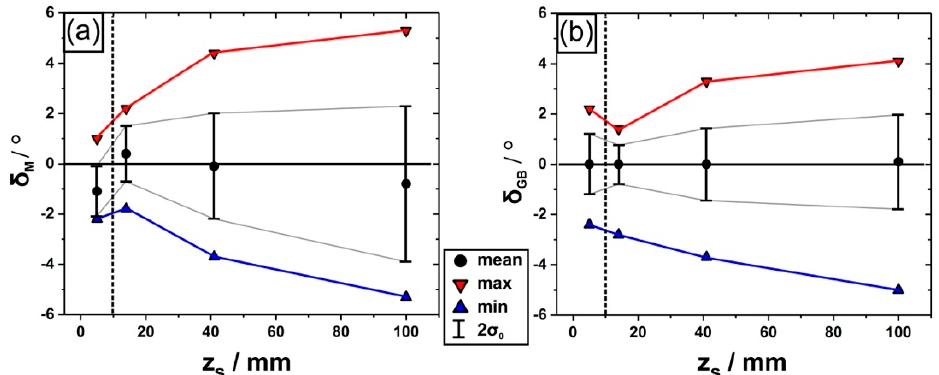
Figure 7. Evolution of dendrite growth directions during solidification with a withdrawal rate of 180 mm/h (same ingot as considered in Figure 6). ( a ) Dendrite growth direction angle δ M . ( b ) Angle δ GB between adjacent dendrites. The vertical dashed lines indicate the position of the transition zone between seed and newly grown crystal.